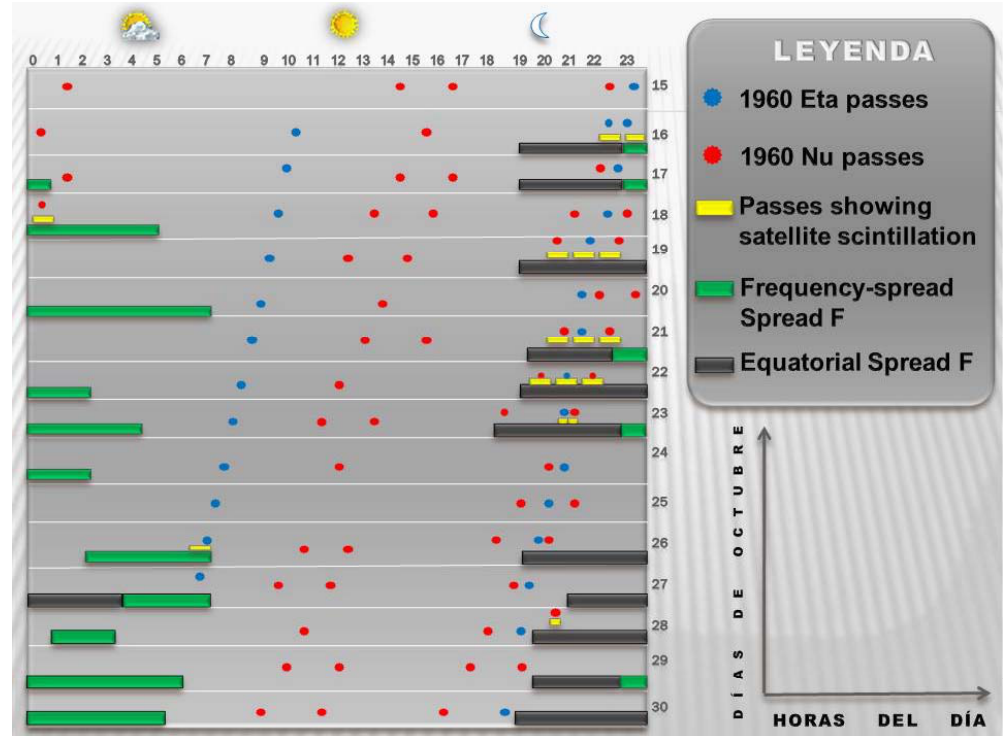
Fig. 3. Graphic showing the state of Spread F for different days, different times of the day and the effect it had on two satellites, 1960 Eta and 1960 Nu. Those passes that have a yellow underline showed satellite scintillation. Notice the good correlation between scintillation and Spread F (adapted from Woodman, 1960)